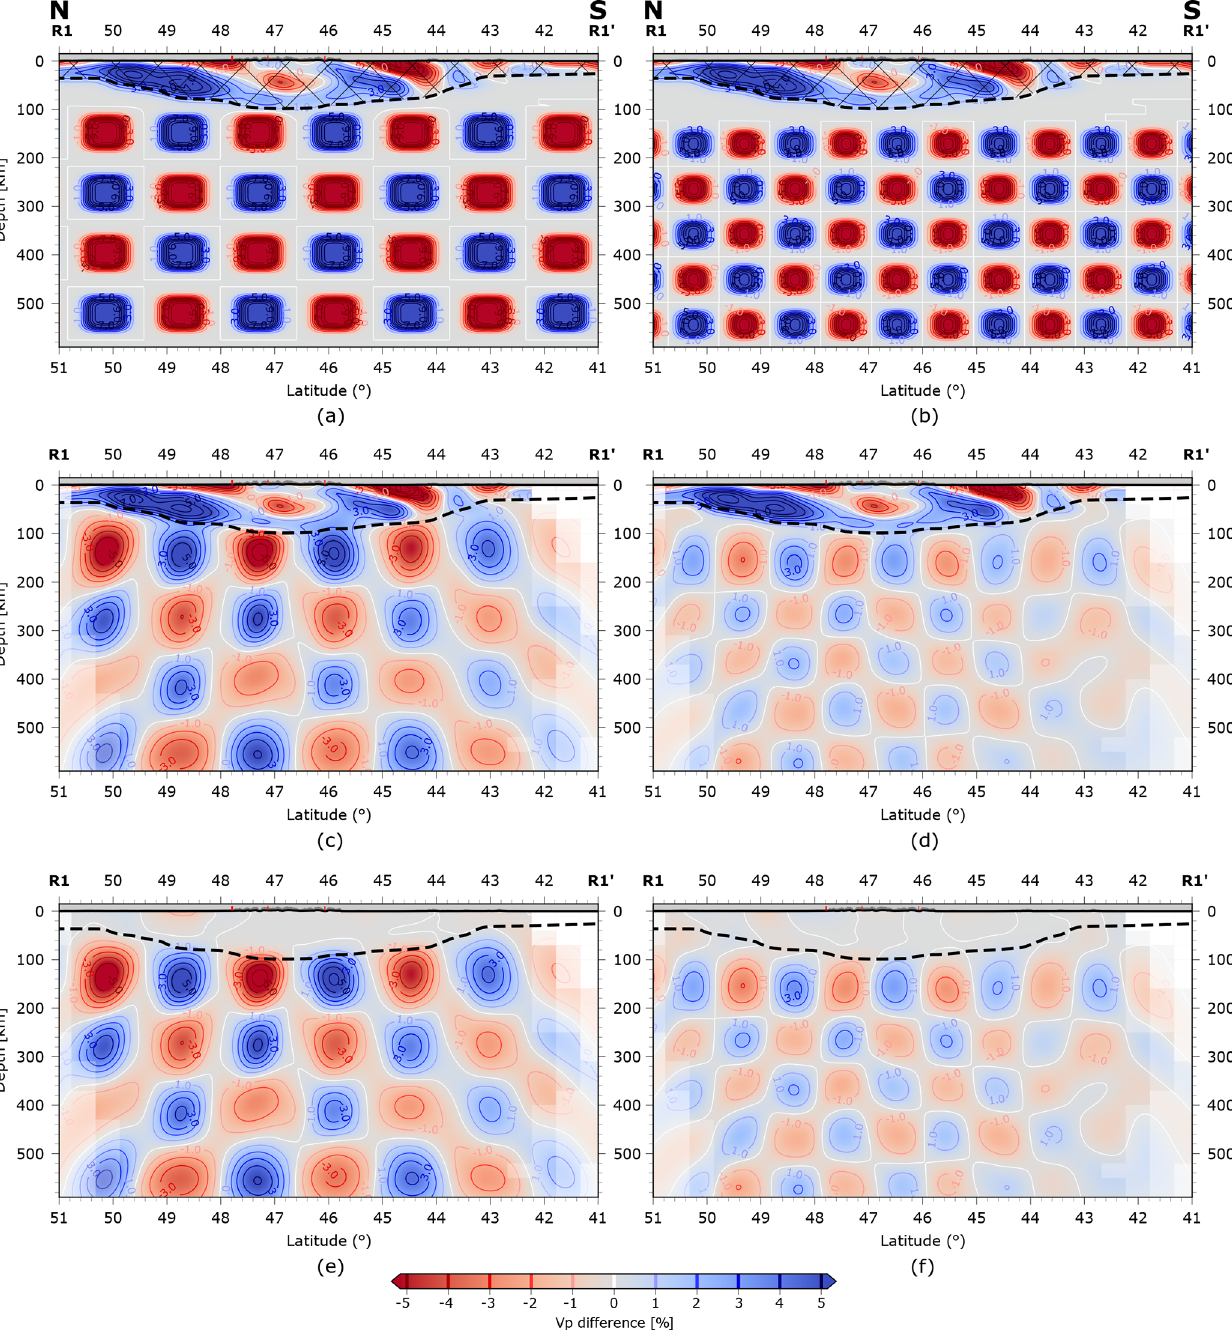
Figure 10. Vertical slices of profile R1 (Fig. 7) cutting through the checkerboard models at 11 . 5 ◦ E. Shown are perturbations of P-wave velocity relative to the 1D reference model (Fig. 4, dotted line). (a, b) Test model used to calculate synthetic data including the a priori crustal model (crosshatched area). (c, d) Recovered checkerboard model including the slightly altered a priori model. Here we can analyse possible interactions between the resolved checkerboard perturbations and the overlying a priori model (e.g. connection of anomalies due to smearing). (e, f) Recovered checkerboard model with the a priori crustal model subtracted. Here we can analyse alterations of the crustal model (artefacts) due to mapping of the checkerboard anomalies into the